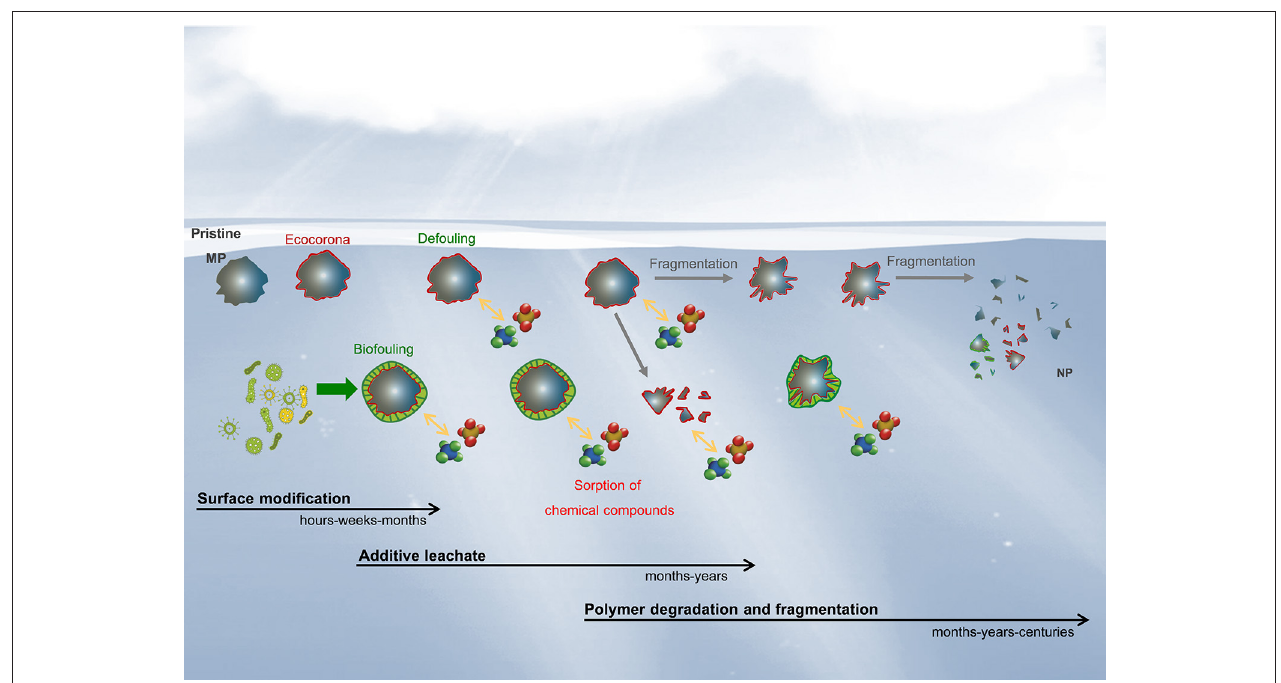
FIGURE 4 | Hypothetical evolution of the physicochemical and biological modifications of microplastics and nanoplastics released in aquatic